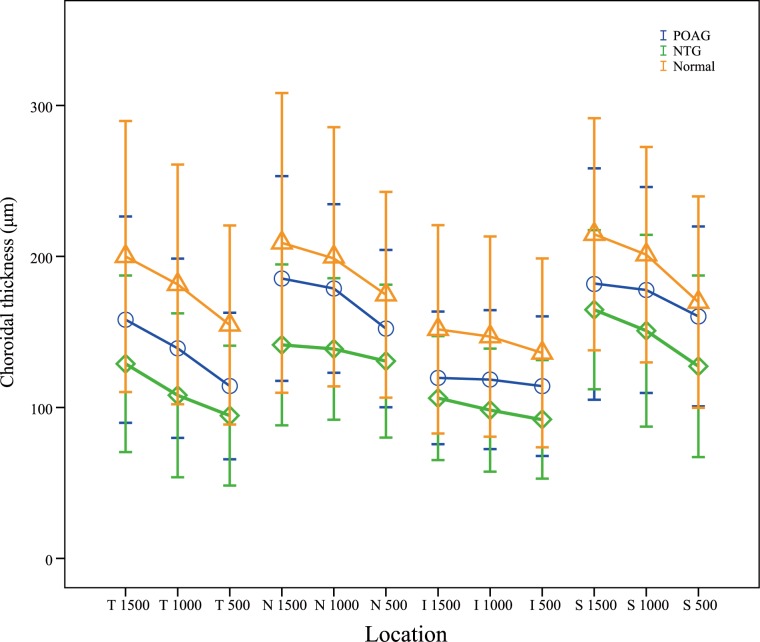
Graph showing the comparison of choroidal thickness in the peripapillary region using the raw data.